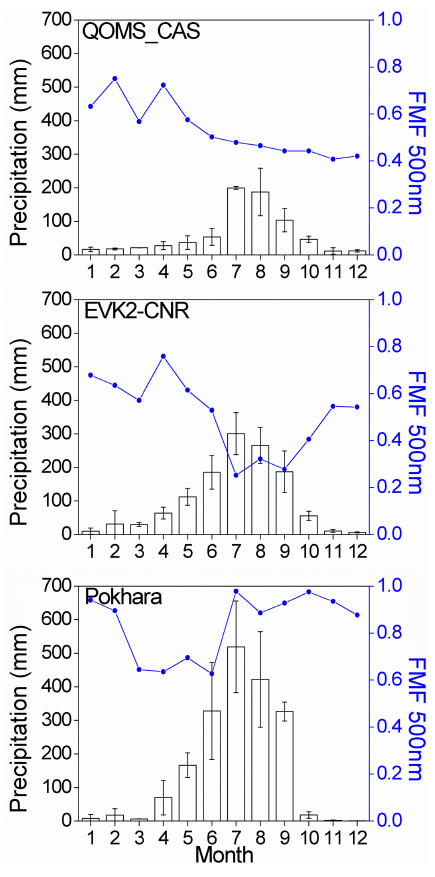
Fig. 7. Monthly means of accumulated precipitation (mm) and fine mode fraction (FMF). The error bars for precipitation indicate the inter-annual